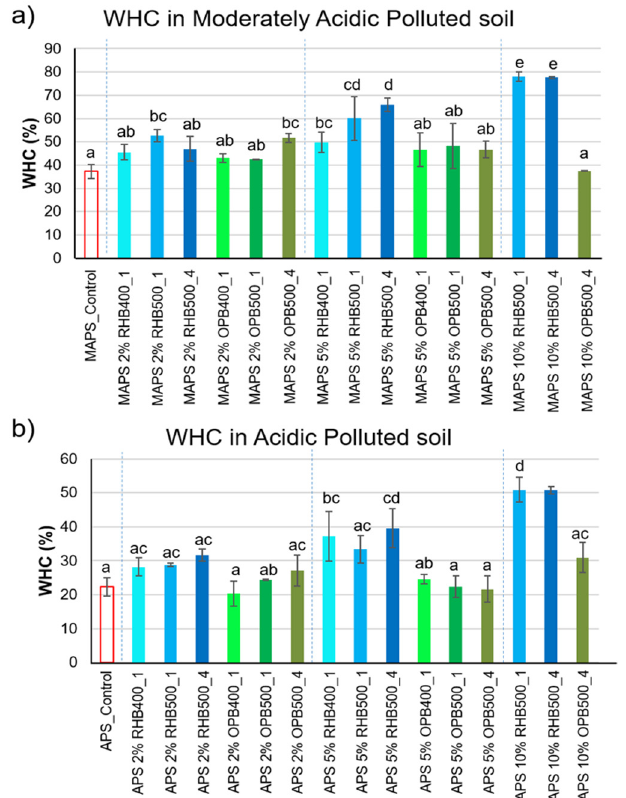
Figure 2. Water-holding capacity in control and amended soils after 65 days of incubation in ( a ) moderately acidic polluted soils (MAPS) and in ( b ) acidic polluted soils (APS). Different letters indicate differences among treatments in each soil ( p < 0.05). Table 2. Elemental analysis of control and biochar-amended soils after 65 days of incubation.